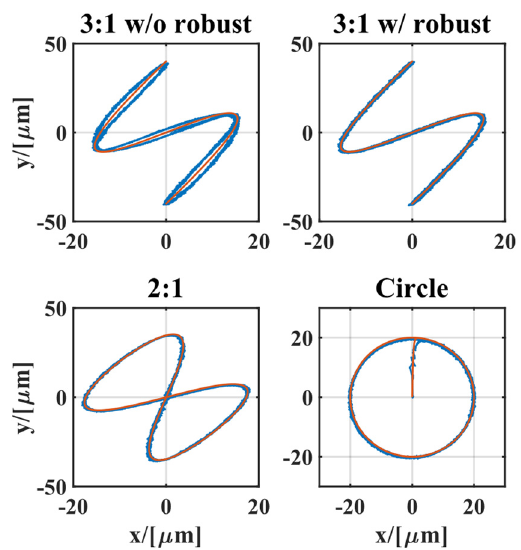
Figure 10. Experiment result showing the CM tracking ( a ) A 2:1 Lissajous curve and ( b ) A circular trajectory.